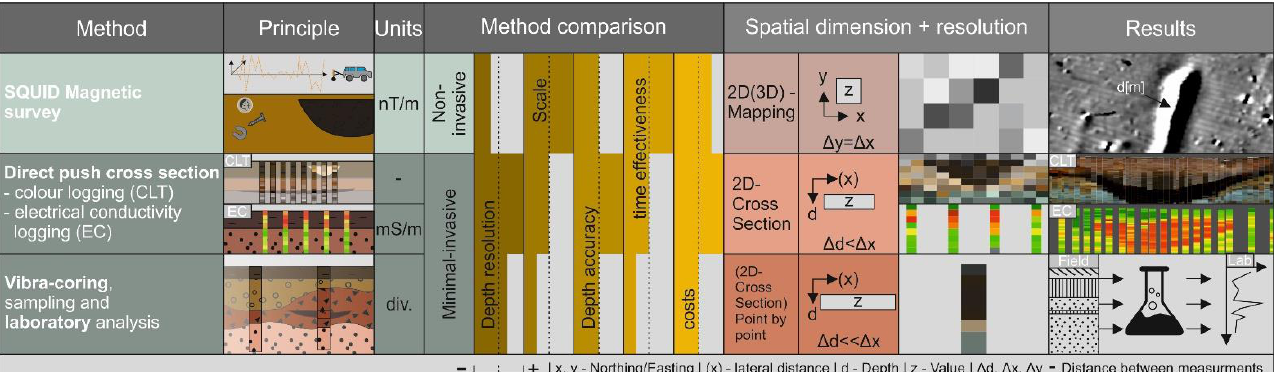
Figure 9. Overview and semi-quantitative comparison of non- and minimal-invasive prospection techniques used at the Fossa Carolina wetland site.